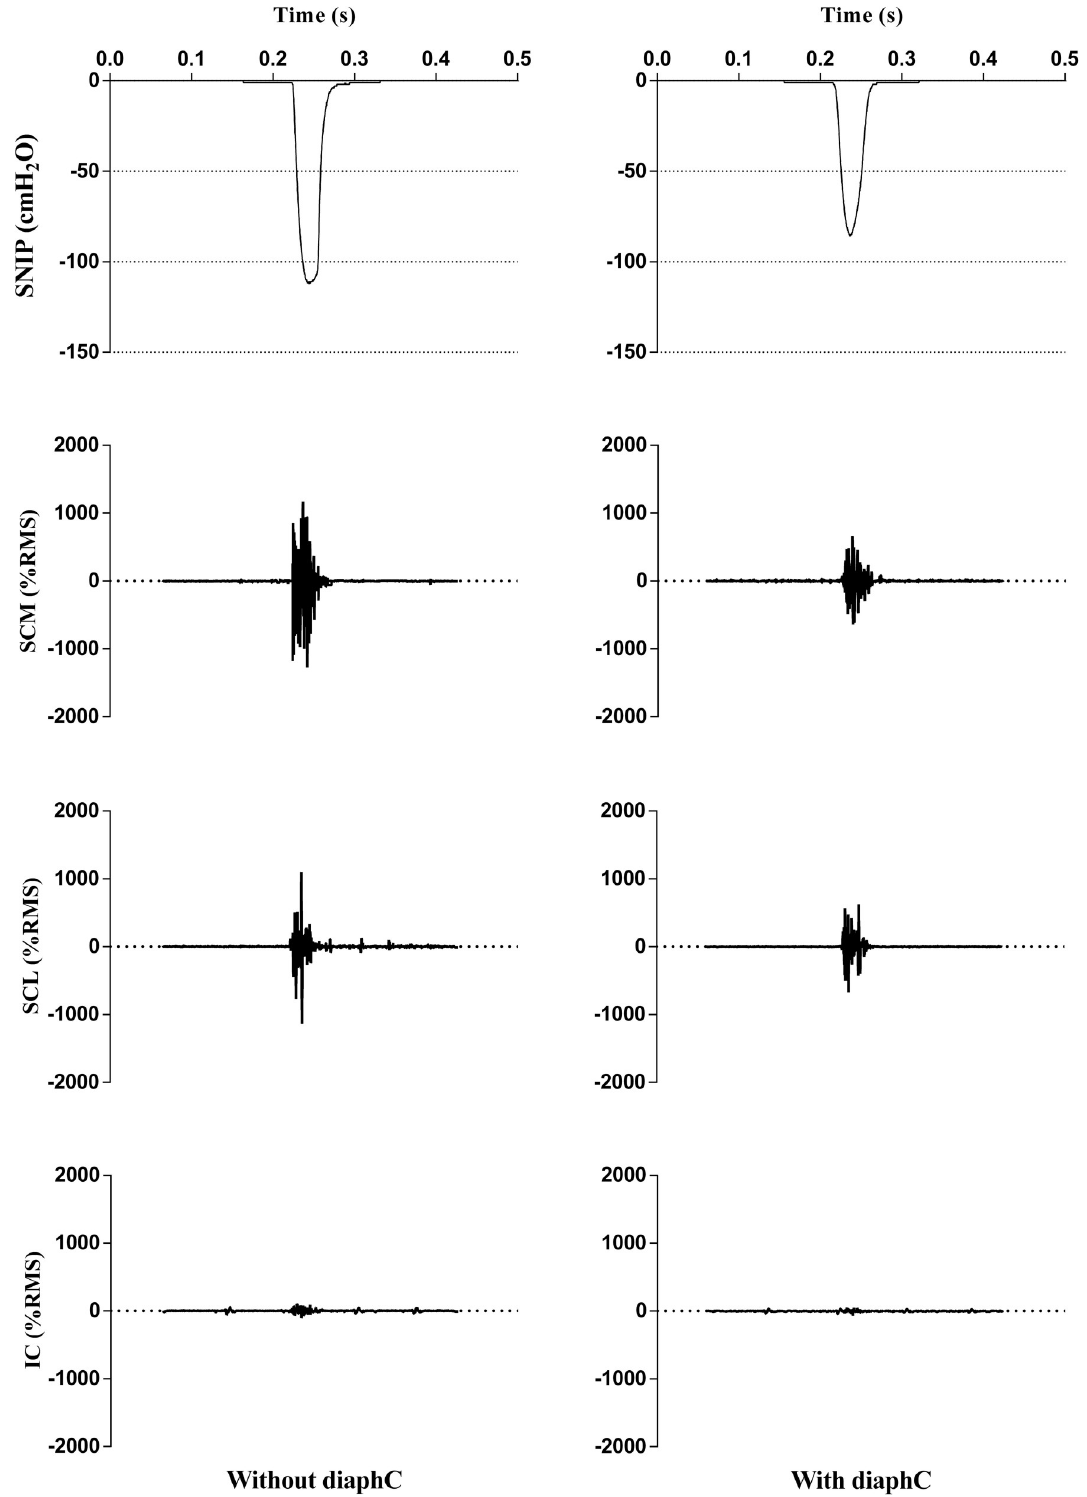
Fig 5. Scalar tracing. Scalar tracing of SNIP and electrical activity of scalene (SCL), sternocleidomastoid (SCM) and intercostal (IC) muscles, during the maneuver with and without diaphC.